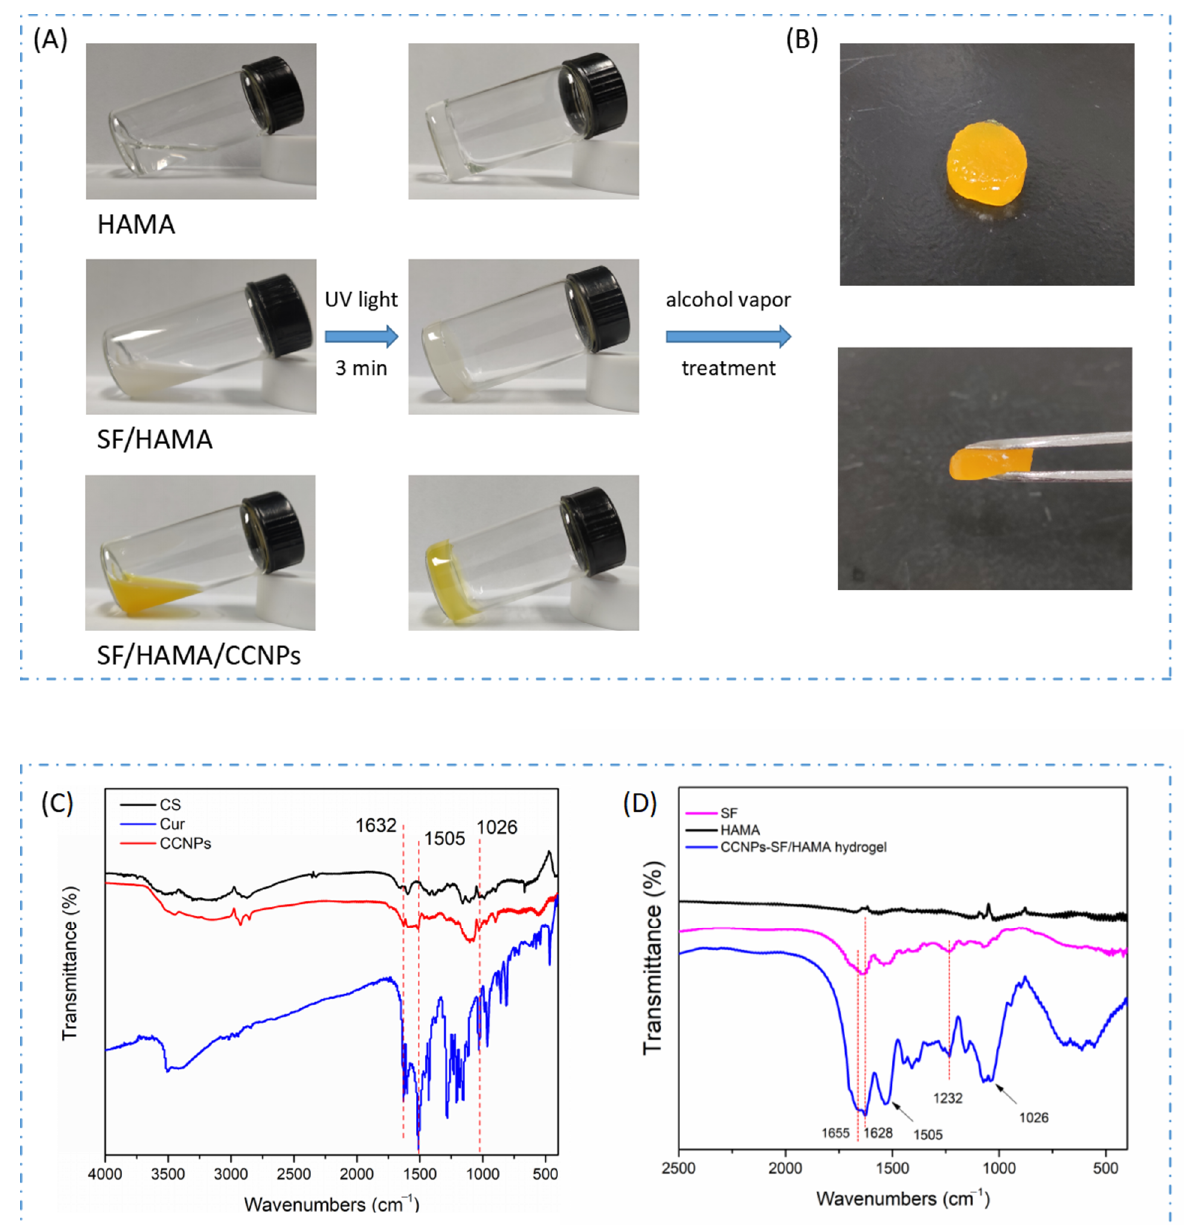
Figure 2. The digital picture of HAMA, HAMA/SF, CCNPs-SF/HAMA hydrogels before and after UV treatment ( A ), The digital picture of CCNPs-SF/HAMA hydrogel after alcohol vapor treatment ( B ), the FTIR spectra of CCNPs ( C ), and CCNPs-SF/HAMA hydrogel ( D ).